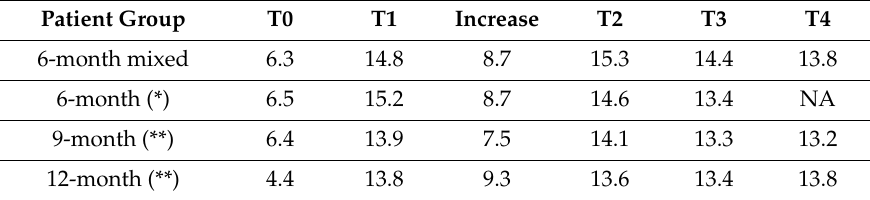
Table 2. Alveolar tissue height measurements on panoramic radiographs (in true mm), overview of the mean values of the 6-month mixed graft group, autogenous bone mixed with Straumann ® bone ceramic (60:40), compared to the 6-, 9- and 12-month results with pure Straumann ® bone ceramic (60:40), as previously published, in a maxillary sinus floor elevation (MSFE) procedure. Tissue height corrected for magnification ( × 1.25) on panoramic radiographs. Patient Group T0